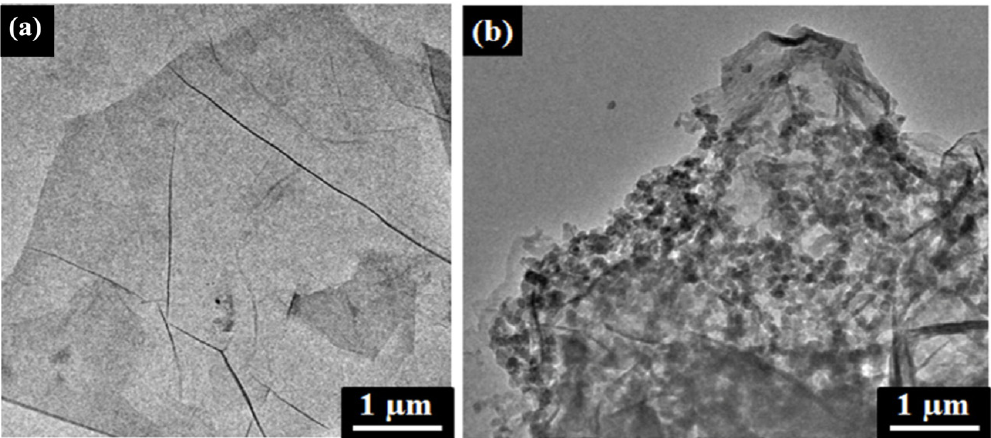
Figure 24. TEM images of ( a ) GO and ( b ) PVK-AZO-GO (Reprinted with permission from [107]; Copyright @ 2018 Else- vier).